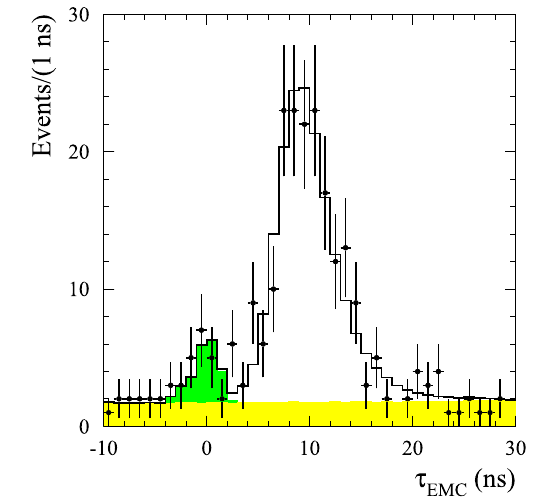
fit described in the text. The light-shaded (yellow) histogram shows the fitted cosmic-ray background. The medium-shaded (green) region represents the fitted beam-induced plus physical background